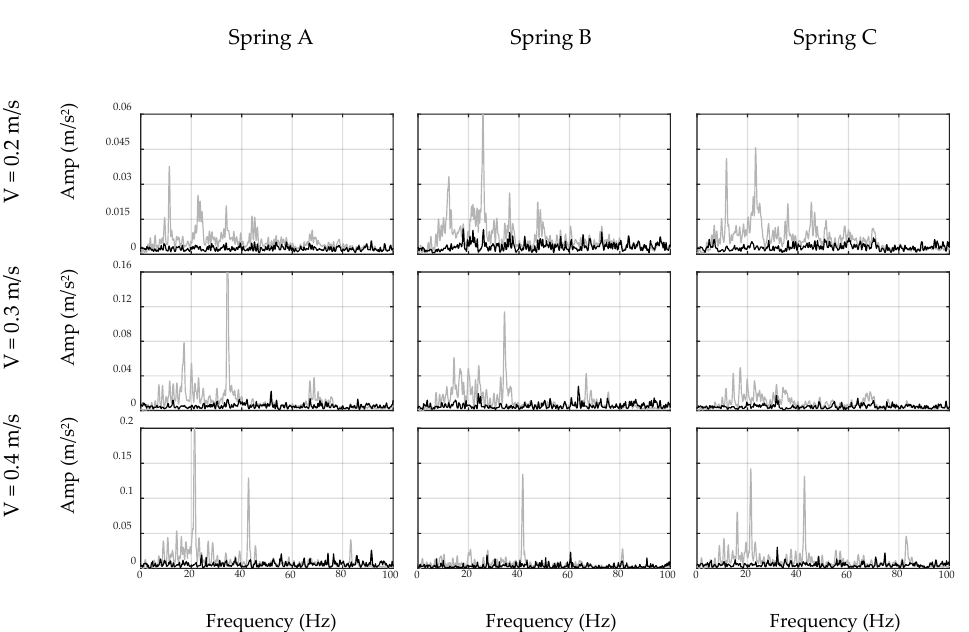
Figure 16. Unfiltered (gray) and filtered (black) spectrums of off-bridge data collected by sensor.